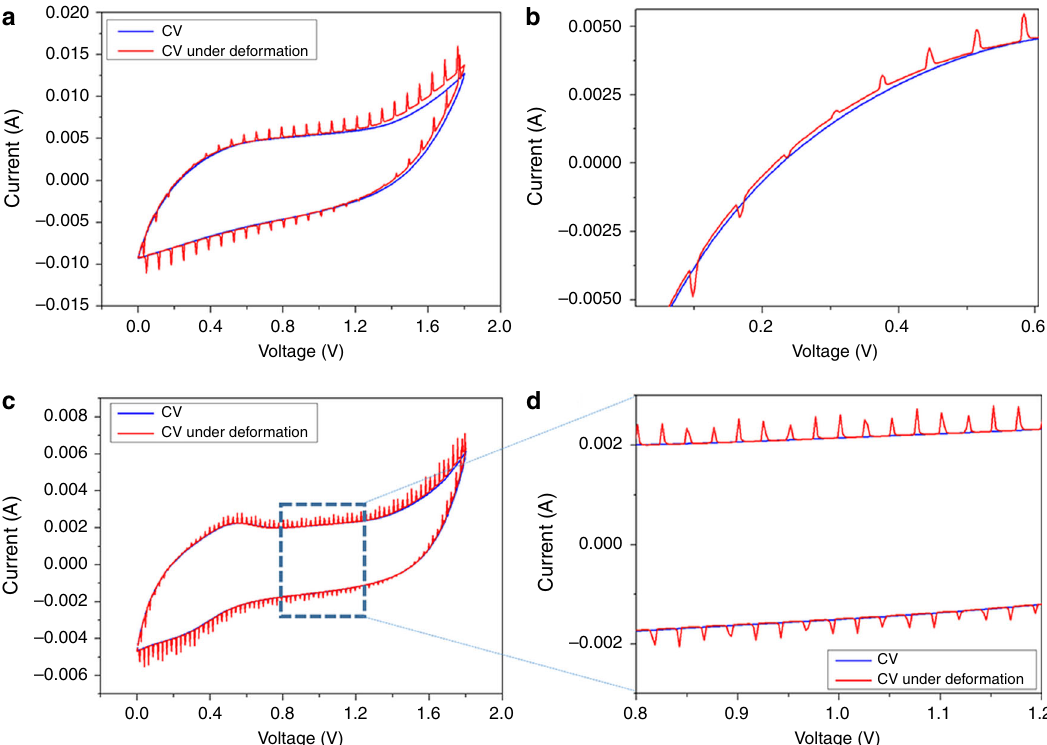
Fig. 8 Piezoelectrochemical spectroscopic measurements of siloxene SCSPC. a PECS measurement using cyclic voltammetry recorded at a scan rate of 100 mV s − 1 , b enlarged portion of Fig. 8a near the PZC region, c PECS measurements recorded using a scan rate of 50 mV s − 1 , and d represents the enlarged portion of Fig. 8c. The siloxene SCSPC device was subjected to an applied compressive force of 20 N during the PECS magnetic stirrer for 4 days. A transformation of color from grayish black (CaSi 2 ) to green (siloxene sheets) indicated the dissolution of calcium in the HCl solution, which led to the formation of siloxene sheets. After the termination of the reaction, the green-colored siloxene powders were washed with water and acetone. Fur-